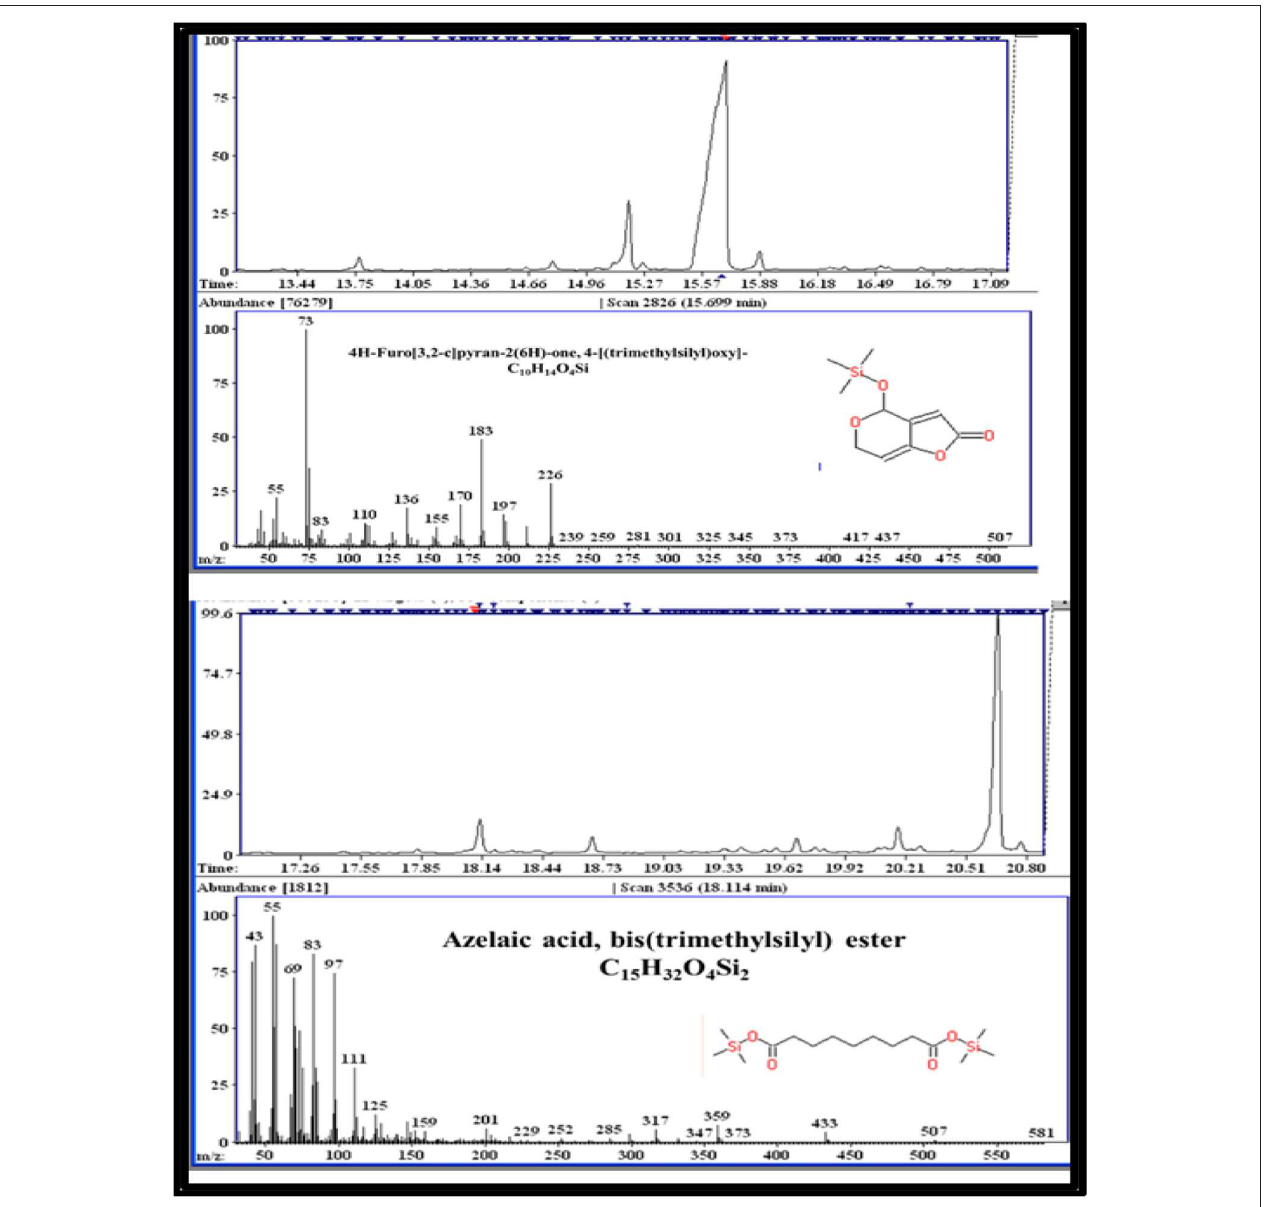
FIGURE 5 | Representative compounds found by GC-MS analysis in ethyl acetate extract of AG 1.2 ( Aspergillus unguis